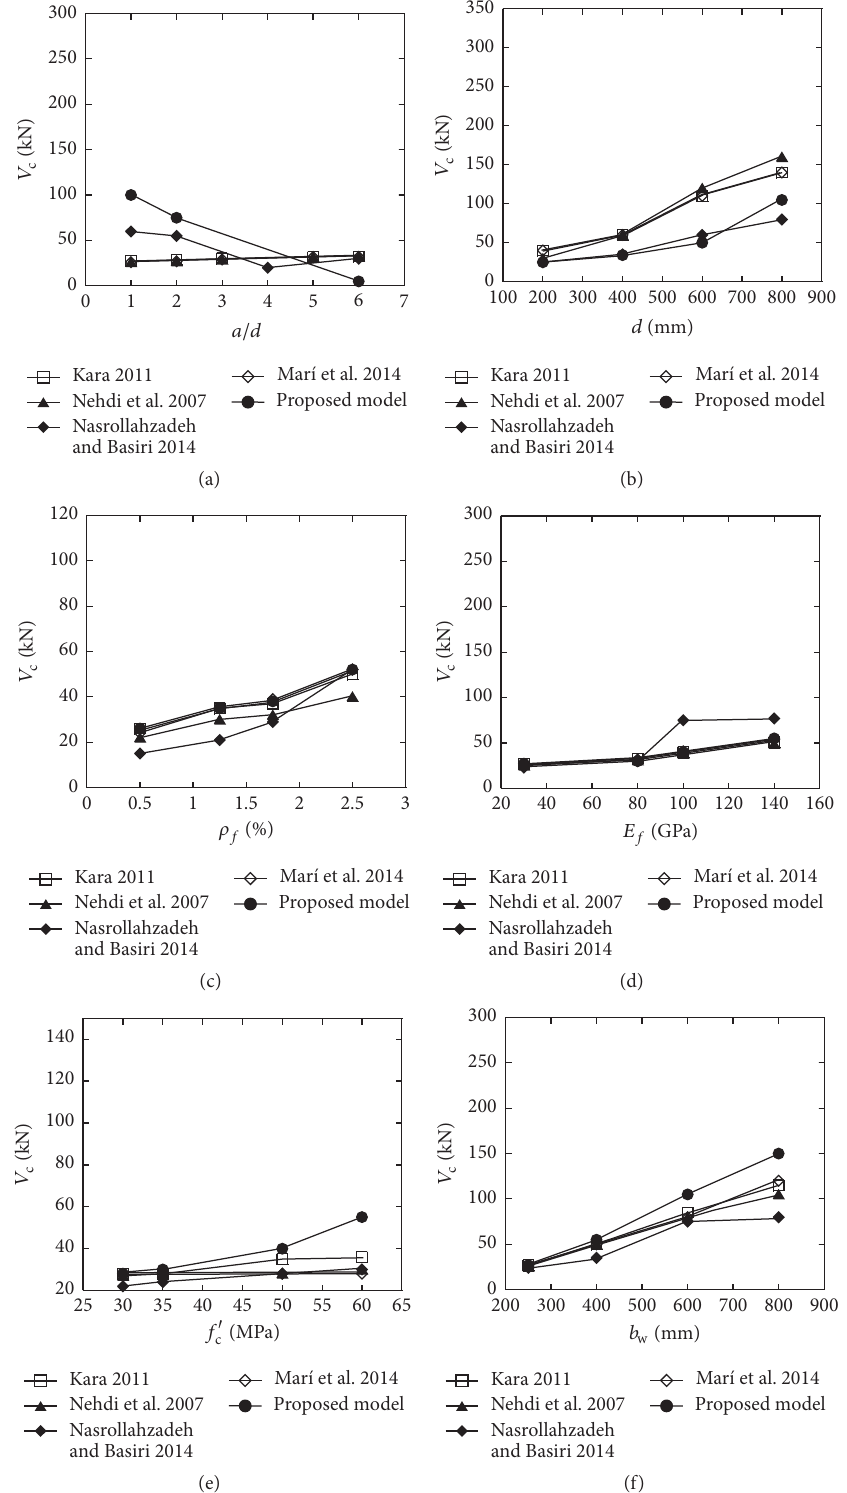
Figure 3: (a) Shear strength of FRP-RC beam with varying shear span to depth ratio ( 𝑎/𝑑 ). (b) Shear strength of FRP-RC beam with varying depth of beam ( 𝑑 ). (c) Shear strength of FRP-RC beam with varying longitudinal reinforcement ratio ( 𝜌 𝑓 ). (d) Shear strength of FRP-RC beam with varying modulus of elasticity of FRP bar ( 𝐸 𝑓 ). (e) Shear strength of FRP-RC beam with varying concrete compressive strength ( 𝑓 󸀠 c ). (f) Shear strength of FRP-RC beam with varying beam width ( 𝑏 w